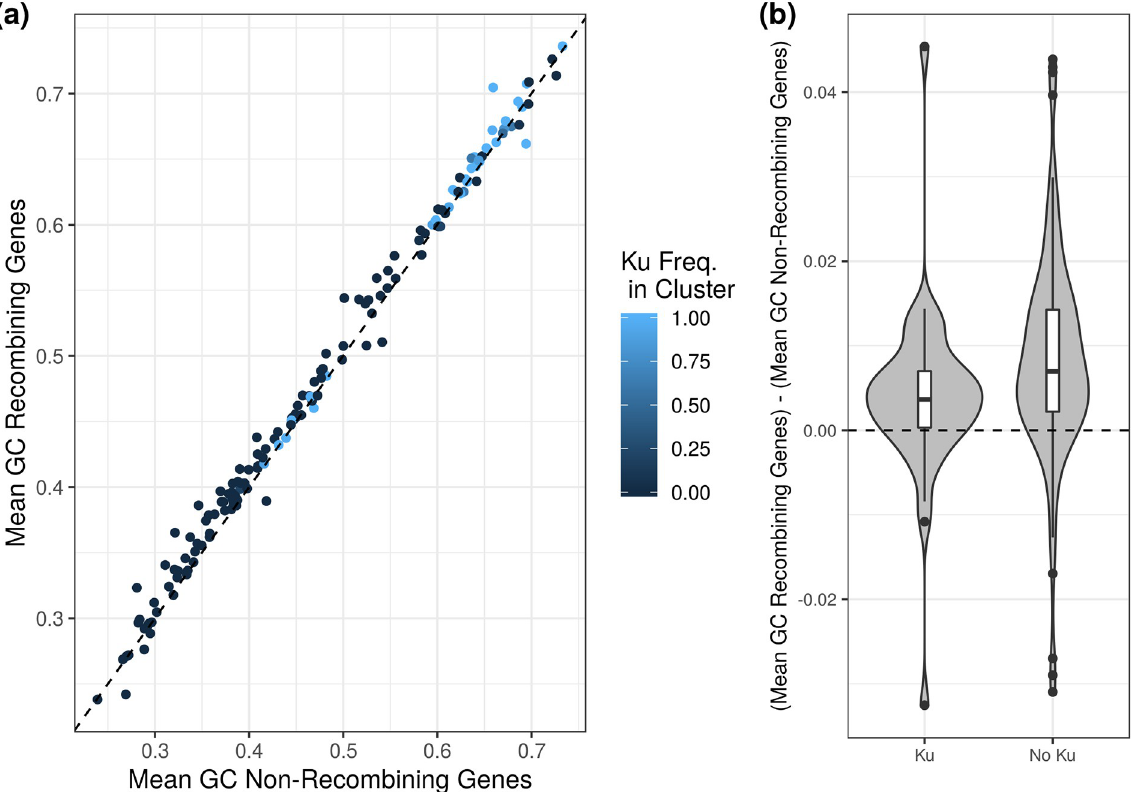
Fig 4. Recombination contributes to GC content locally but cannot explain the relationship between GC content and Ku incidence. (a) The mean GC content of genes with evidence for recombination (PHI statistic, [45], see Methods) plotted against the mean GC content of genes without evidence for recombination in a given closely related cluster of organisms (ATGC database [42]). Recombining genes have slightly higher GC content than non-recombining genes (points mostly lie above the dashed x = y line). (b) The difference in GC content for recombining and non-recombining genes within a cluster is smaller for Ku-encoding than Ku-lacking clusters. Clusters classified as Ku-lacking if no members encoding Ku ( n = 114) and Ku-encoding if at least one member has Ku ( n = 41). Clusters excluded if no evidence for recombination was found for any of their